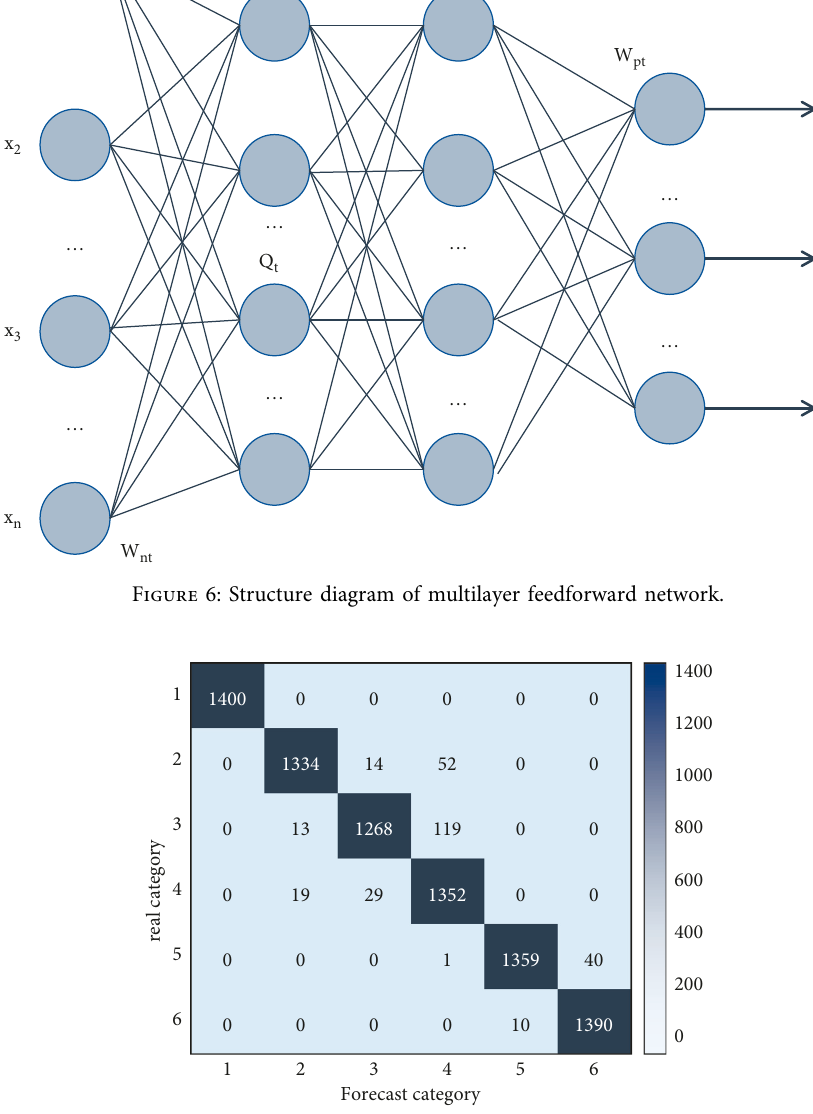
Figure 7: Individual identification results of GBDT mobile devices.